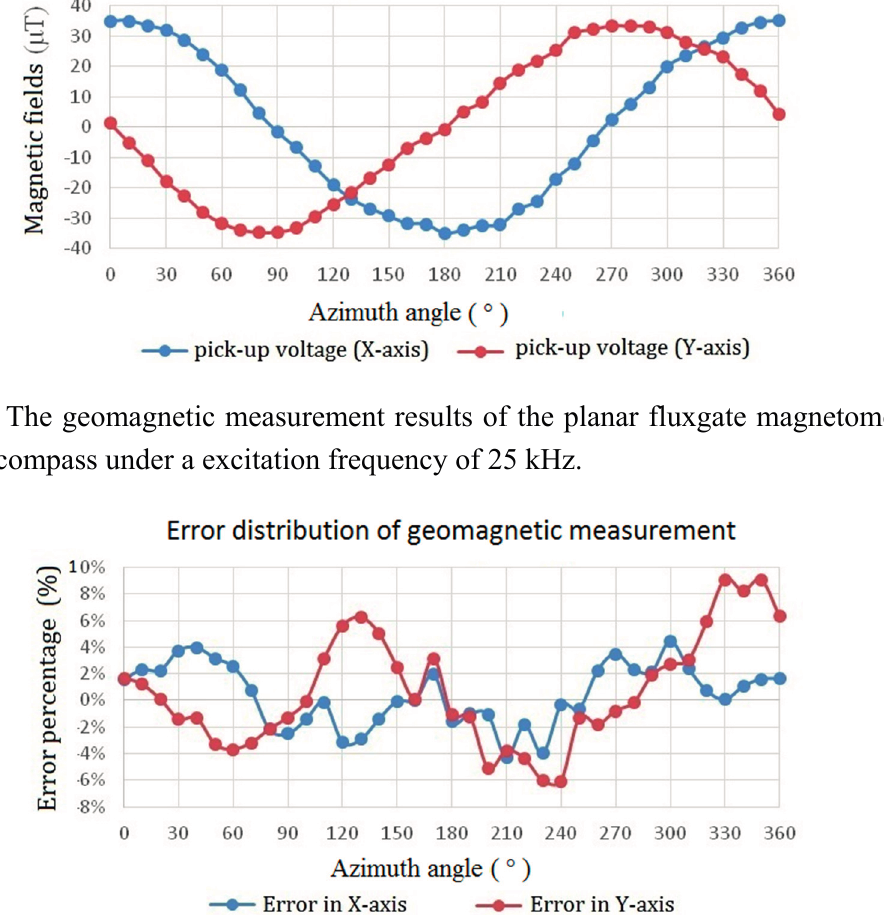
Figure 16. The error distribution of geomagnetic measurement for the in-plane axes with respect to the azimuth